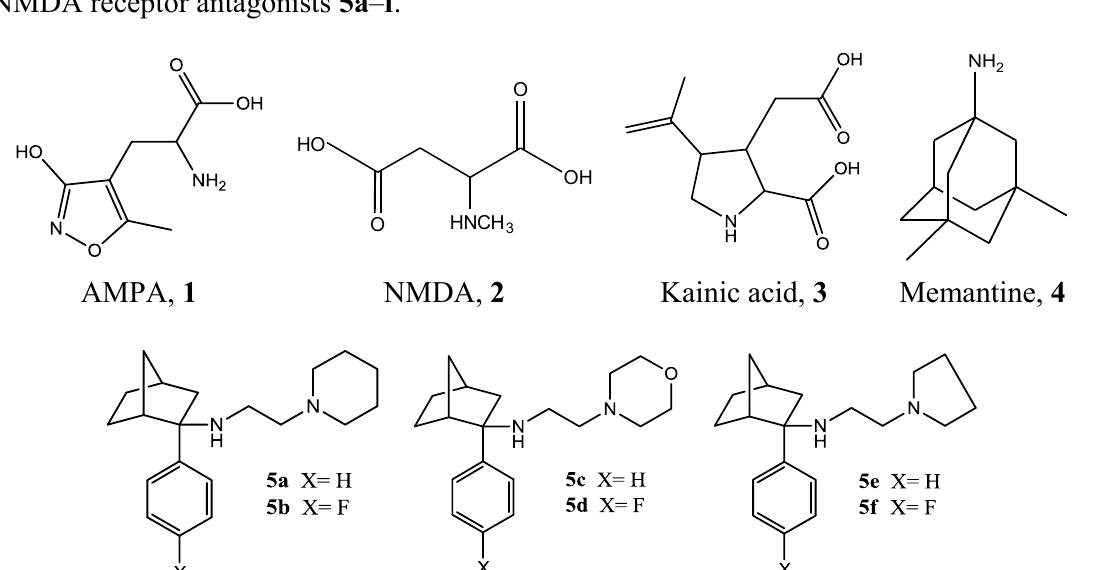
Figure 1. Structures of AMPA, NMDA, kainic acid, memantine and designed novel NMDA receptor antagonists 5a – f